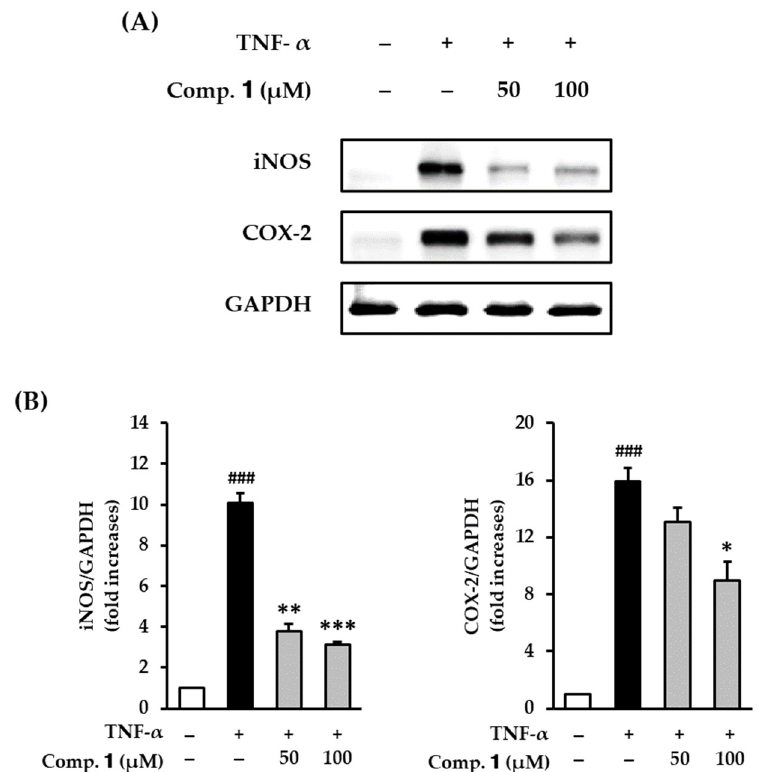
Figure 3. Effects of 1,3-dihydroxy-2,8-dimethoxy-6-methylanthraquinone ( 1 ) on COX-2 and iNOS protein expression in TNF- α -stimulated HDFs. HDFs were untreated or treated with TNF- α , followed by treatment with 1 for 6 h. The levels of protein expression were determined using Western blot analysis. ( A ) The protein expression of iNOS, COX-2, and GAPDH. ( B ) The graphs of relative protein expression levels of iNOS and COX-2. The data are presented as mean ± SEM of at least three independent experiments. ### p < 0.001 difference compared to untreated cells. * p < 0.05, ** p < 0.01 and *** p < 0.001 difference compared to TNF- α -stimulated cells.